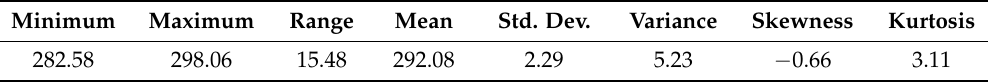
Table B5. Statistics of the dew-point temperature distribution [K].